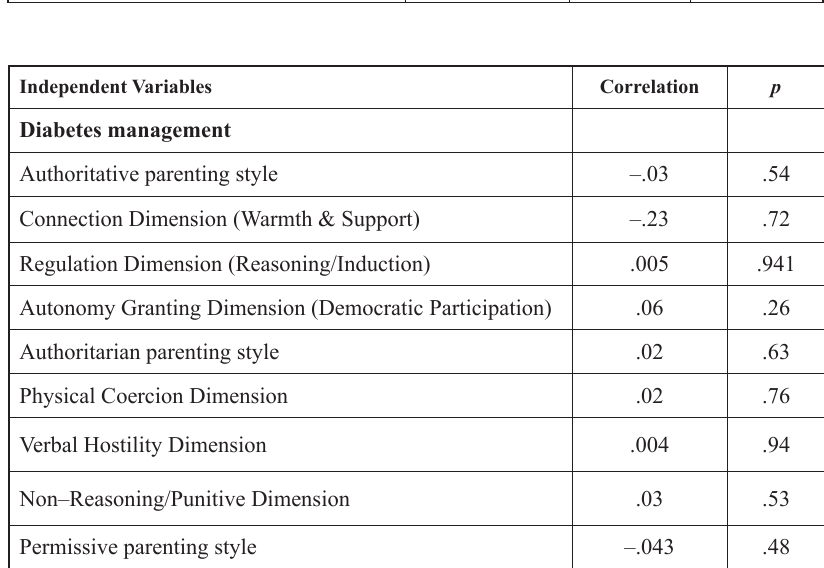
Table 5. Correlation between children T1DM management and PS scales and subscales of mothers ( N = 131)